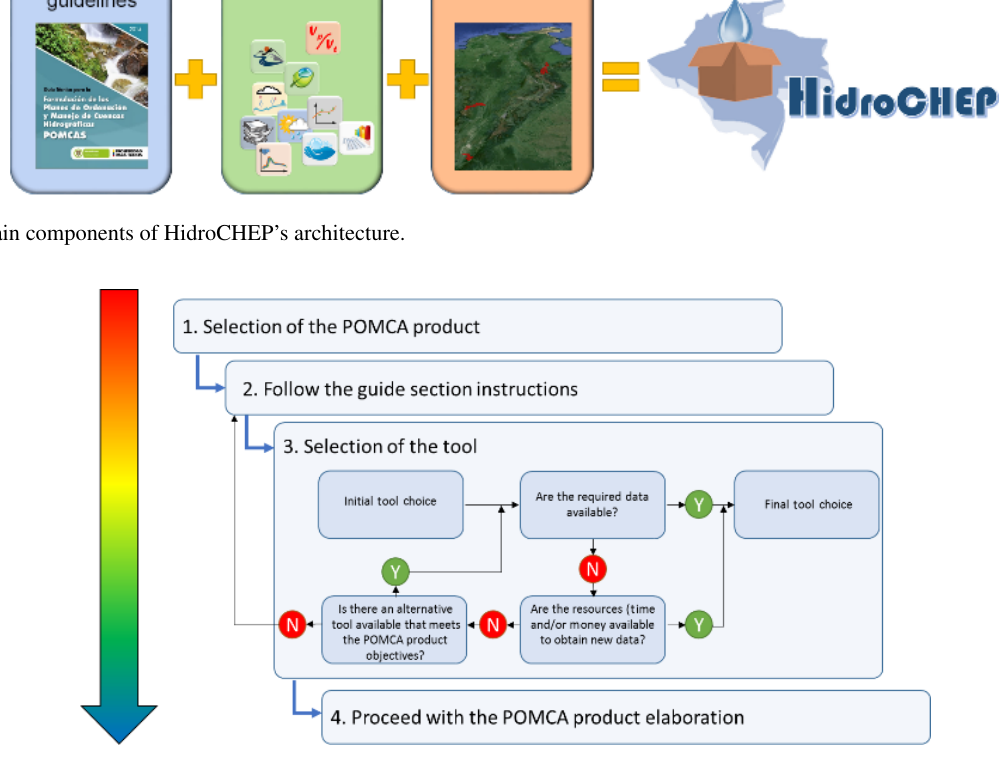
Figure 2. Flowchart of the use of HidroCHEP for the elaboration of a POMCA